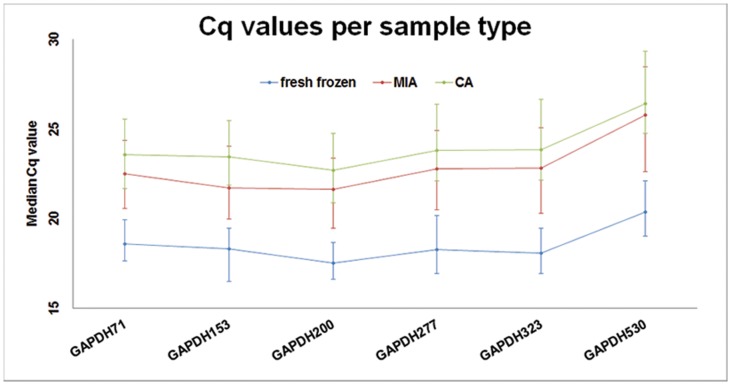
GAPDH size assay in fresh frozen, MIA and CA samples.The median Cq values (X-axis) of RNA derived from fresh frozen, MIA and CA samples obtained by RT-qPCR with various PCR product lengths (Y-axis) are shown. The fresh frozen samples always show lower Cq values, whereas the MIA samples show intermediate and the CA samples show high Cq values. This indicates that RNA in MIA samples is less degraded than RNA in CA samples. The parallel increasing Cq values between GAPDH323 and GAPDH530 indicate suboptimal RT-qPCR performance, rather than decreased GAPDH expression levels.